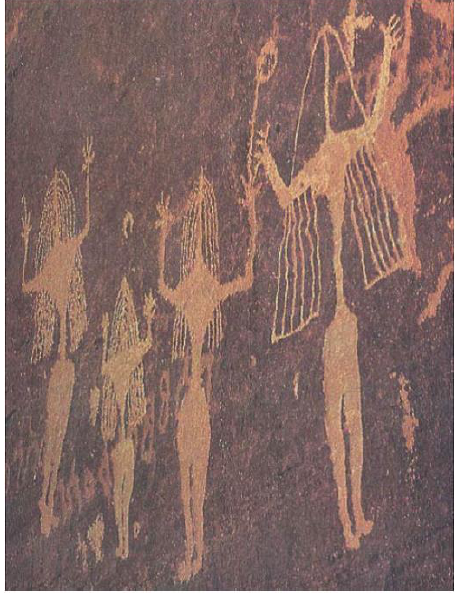
Figure 15. Female figures superimposed on earlier Bedouin inscriptions suggest their literate period age ca. 2500–2000 BP. Triangular torso, long neck, narrow waist, wide buttocks, and long hair are not less than the specifications of present day Miss World. We may assume that the artist may have deliberately kept the face obscure. The local Bedouin call it the image of a goddess “Alia”, a prehistoric queen and goddess ruling all over Southern Arabia. Although it is a legend, and apparently seems to be a story, this is the only figure in Arabian rock art with ethnological information. Images of Alia are overwhelmingly depicted on many sites in Najran area and further south in Northern Yemen.